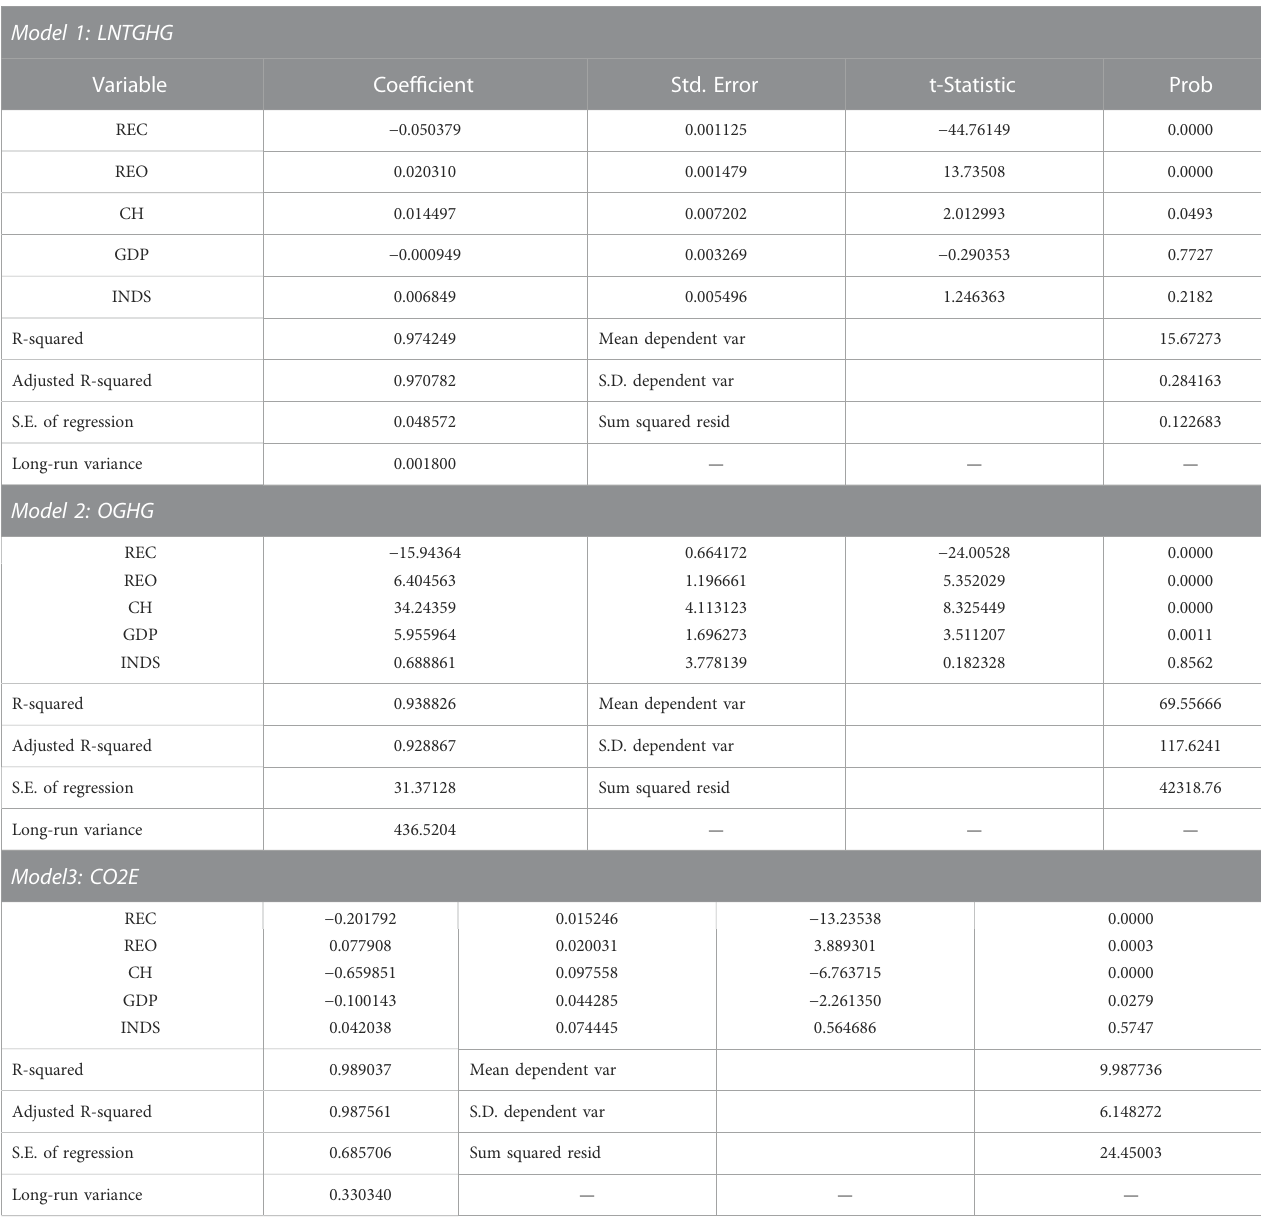
TABLE 10 Results of